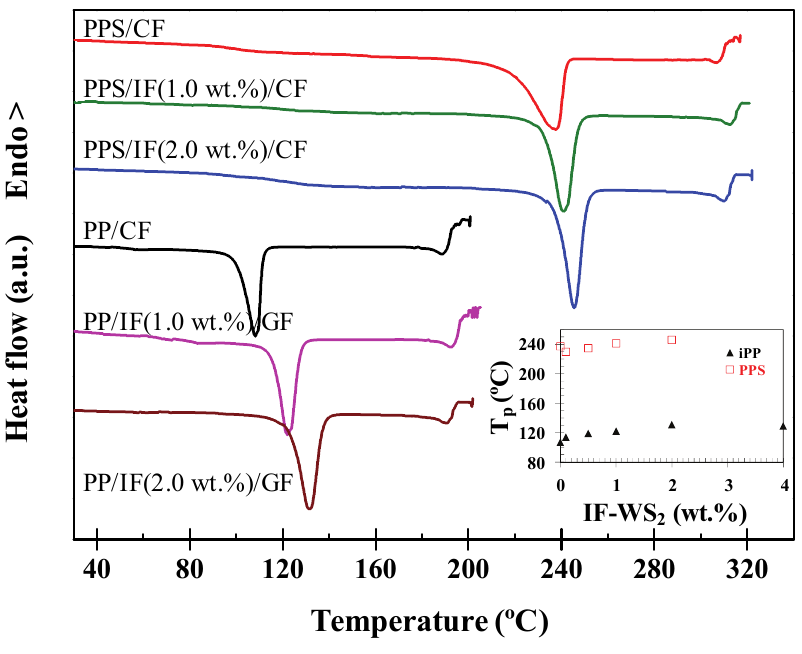
Figure 3. DSC crystallization thermograms for neat iPP, PPS and some IF-WS reinforced multiscale laminates. The inset shows the crystallization peak temperature T